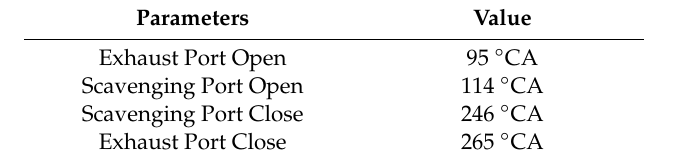
Table 2. Intake and exhaust valve timing of the initial prototype engine.